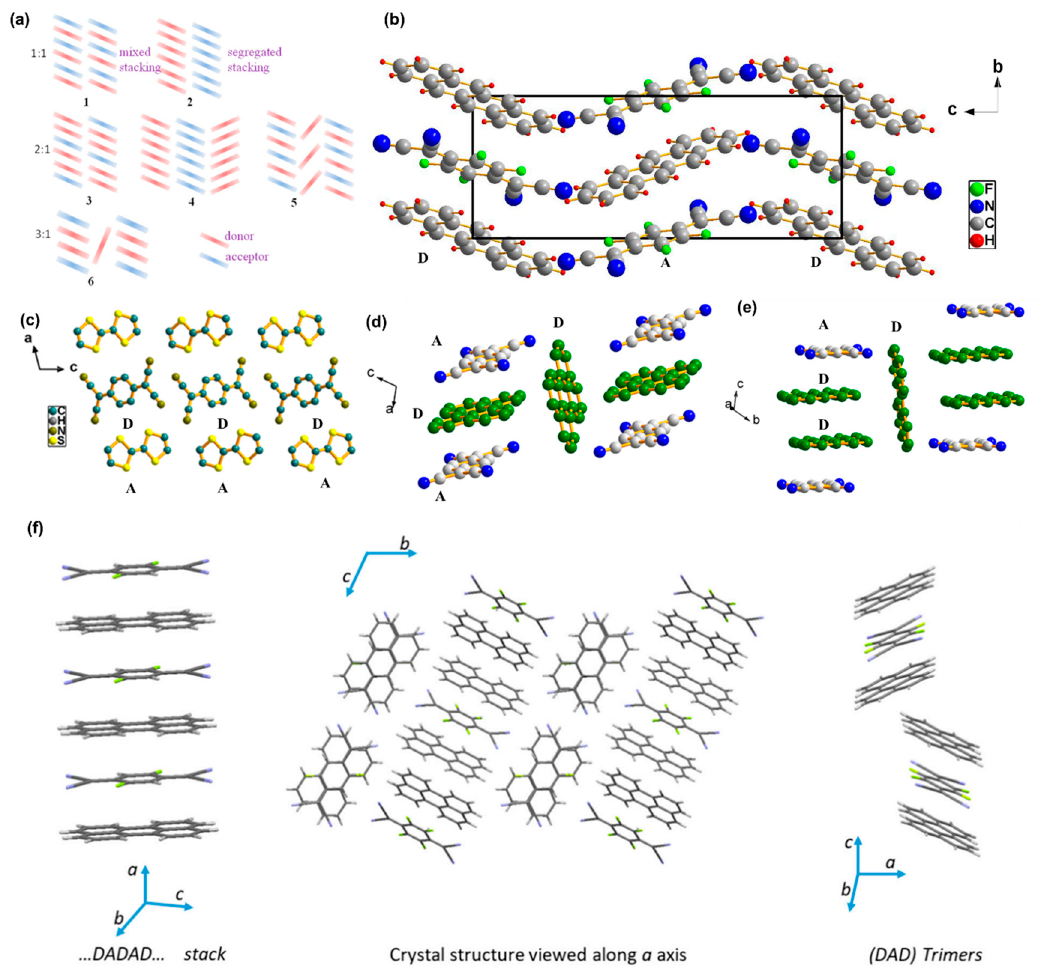
Figure 8. ( a ) Schematic representations of CTCs with di ff erent molecular packing. The red and blue rectangles represent the donor and acceptor constituents, respectively; ( b ) Crystal packing of the tetracene-F 4 TCNQ along the (100) direction; ( c ) Crystal packing of the TTF-TCNQ; ( d ) Crystal packing of the (perylene) 2 -(TCNQ) 1 ; ( e ) Crystal packing of the (perylene) 3 -(TCNQ) 1 ; ( f ) Crystal packing of the (perylene) 3 -(F 4 TCNQ) 2 . ( a ) is reproduced with permission from [2]; ( b ) is reproduced with permission from [42]; ( c ) is reproduced with permission from [6]; ( d , e ) are reproduced with permission from [37]; ( f ) is reproduced with permission from [66].